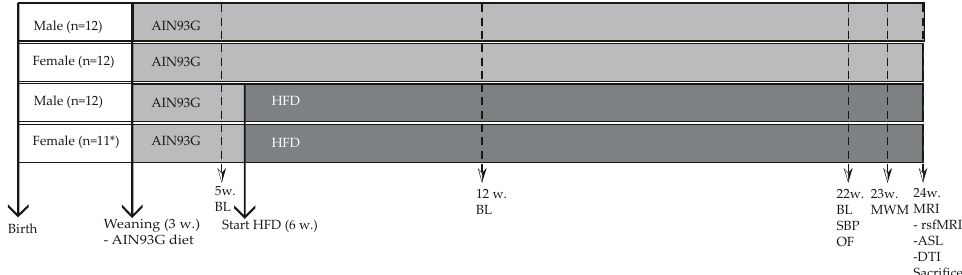
Figure 1. Study design: Food intake (at cage level) and body weight (individual) were weekly measured. Blood samples were taken after 5 h of fasting (8 a.m.–1 p.m.), and collected at three time points (5, 12 and 22 weeks (w)). Cognitive and MRI experiments were performed at 24 weeks of age. At the end of the experiment, all mice were anaesthetized and sacrificed by transcardial perfusion with 0.1M phosphate-buffered saline (PBS, 7.3 pH, room temperature). Thereafter, several organs (liver, adipose tissue and brain) were harvested and used for biochemical and immunohistochemical experiments. Gray: period fed a low-fat reference AIN93G diet. Deep gray: period of HFD feeding. BL = blood sample collection. MWM = Morris water maze test; SBP = systolic blood pressure measurements; OF = open field test; MRI = examined with magnetic resonance imaging for resting state fMRI (rsfMRI), arterial spin labeling (ASL) and diffusion tensor imaging (DTI). * 1 female mouse was sacrificed due to severe inflammation on the base of the tail.